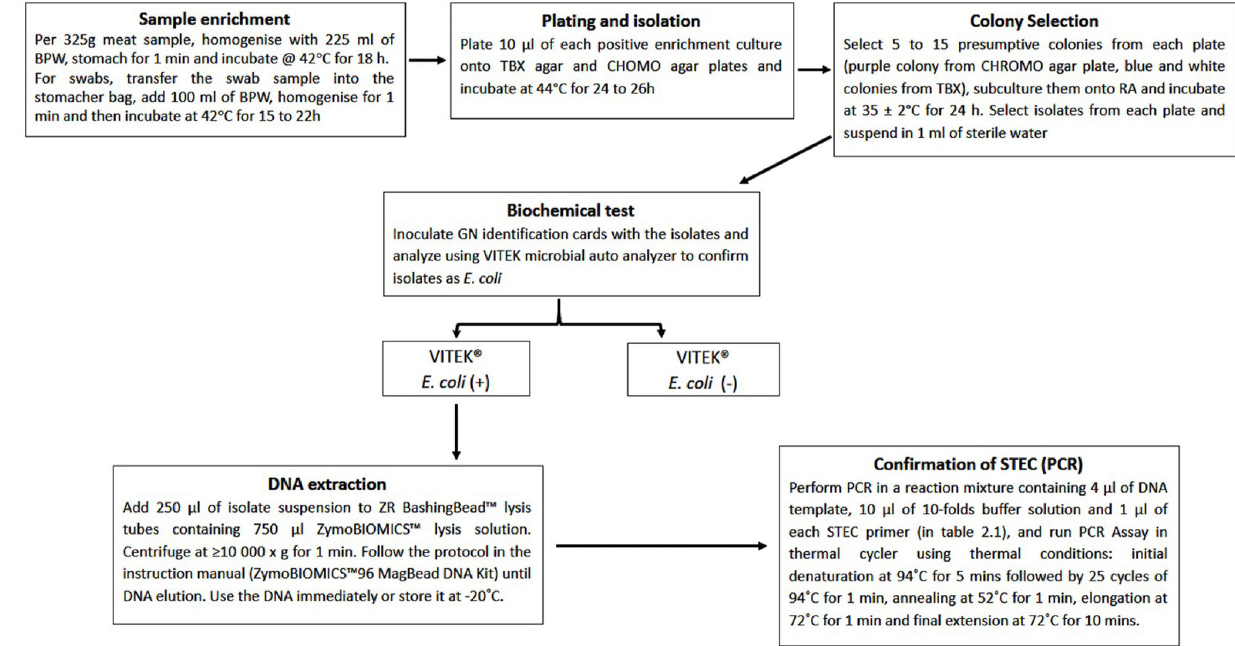
Fig 1. Summary of sample analysis. All the samples were first enriched then cultured on both TBX and CHROMagar plates. Biochemical test was then done on positive bacterial colonies and PCR was used to confirm STEC done on the positive presumptive bacterial samples using specific primers.